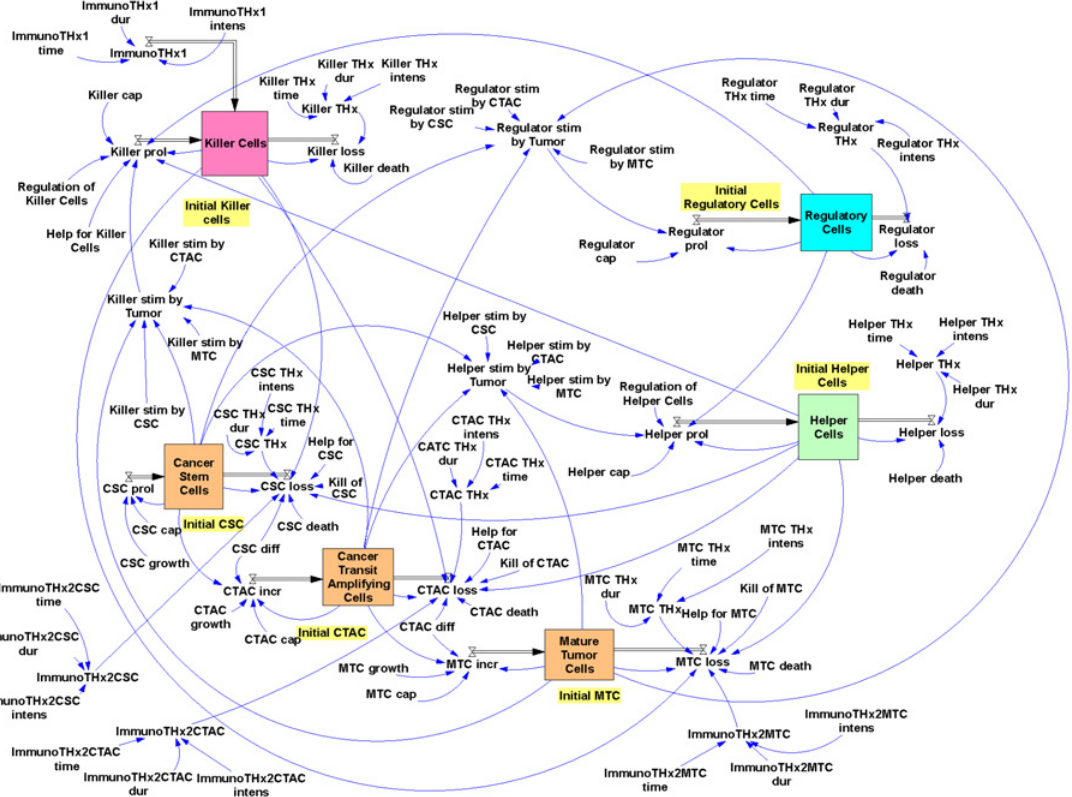
Fig 3. The Hodgkin ’ s lymphoma model. A snapshot from the model programmed in Vensim is presented. Details are explained in the